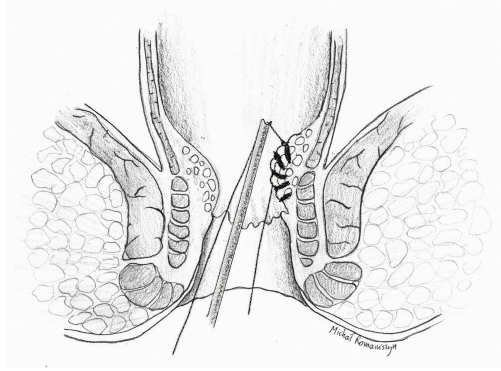
Figure 4: Haemorrhoid lifted back into its anatomical position by tying the